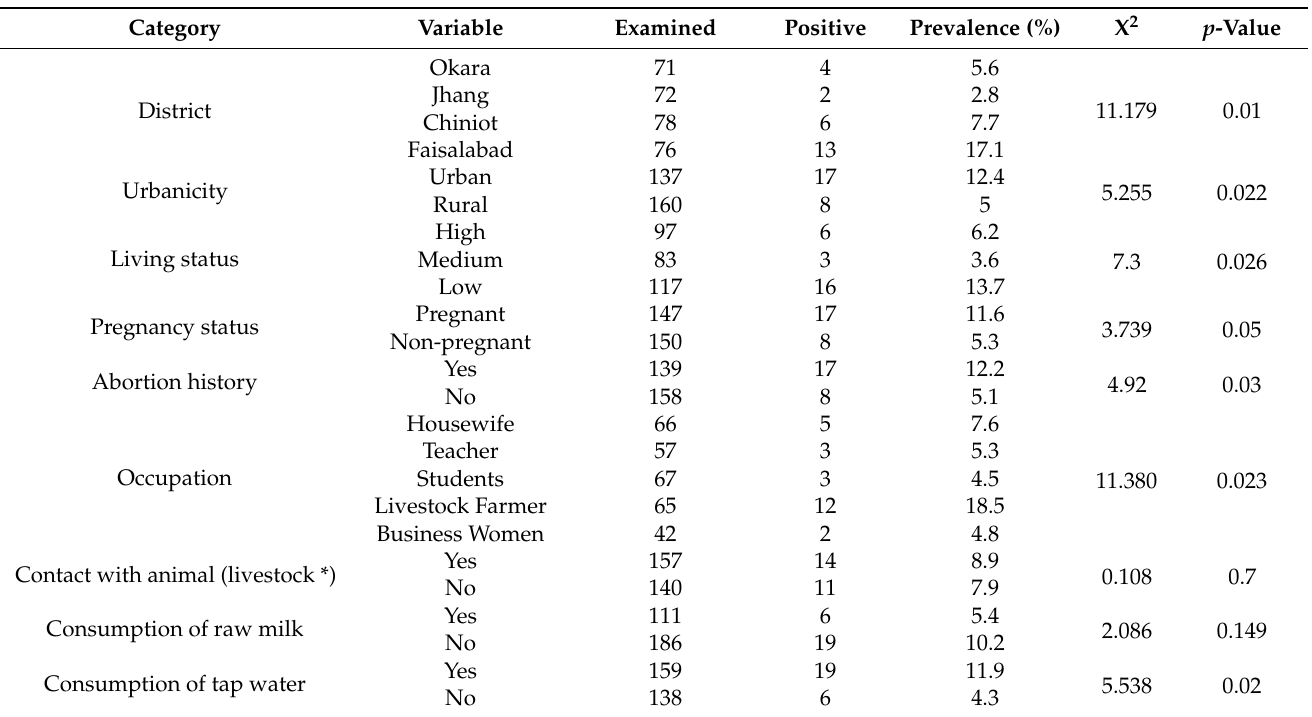
Table 1. Seroprevalence of C. burnetii antibodies based on epidemiological and demographic factors in women of Punjab, Pakistan, by using Chi-square analysis.